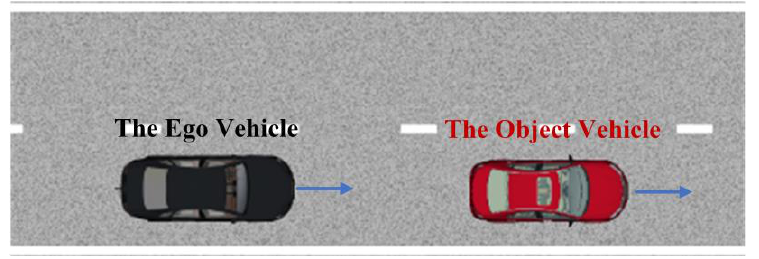
Figure 16. The ODD of the car-following scenario. The red vehicle denotes the object vehicle, and the black vehicle denotes the ego vehicle.